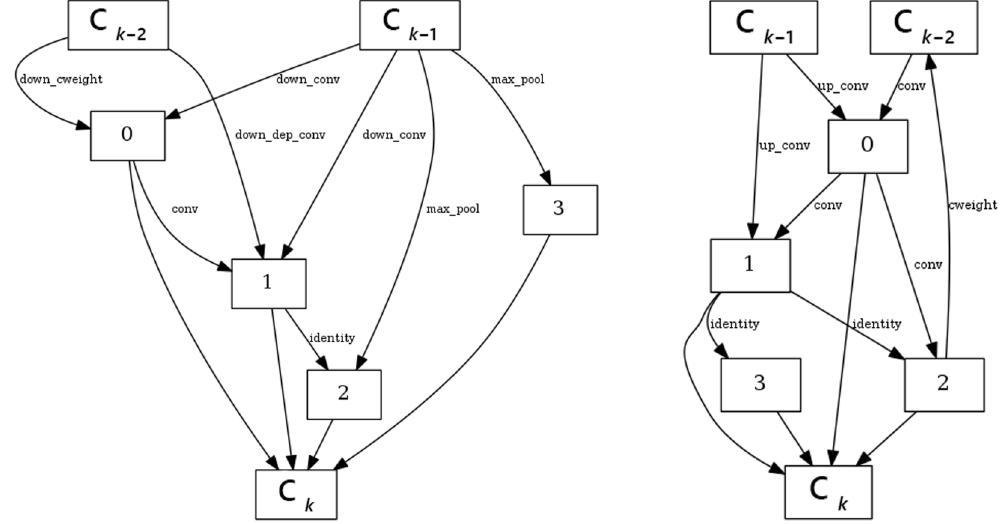
Figure 8. Visualization of NAS-MACU-V8 cell genotypes (DownSC ( left ) and UpSC ( right )) with four intermediate nodes.